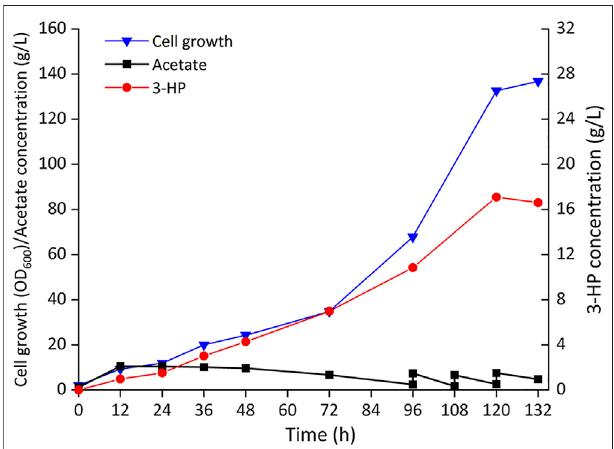
FIGURE 6 | Time pro fi les of cell growth (OD 600 ), acetate, and 3-HP concentrationsduringthefed-batchcultureofrecombinantstrainCgz14/sod- N-C* in a 5-L bioreactor. Pure acetate was added automatically into the broth to maintain pH at 7.0; 14 g sodium acetate was added externally at 96, 108, and 120